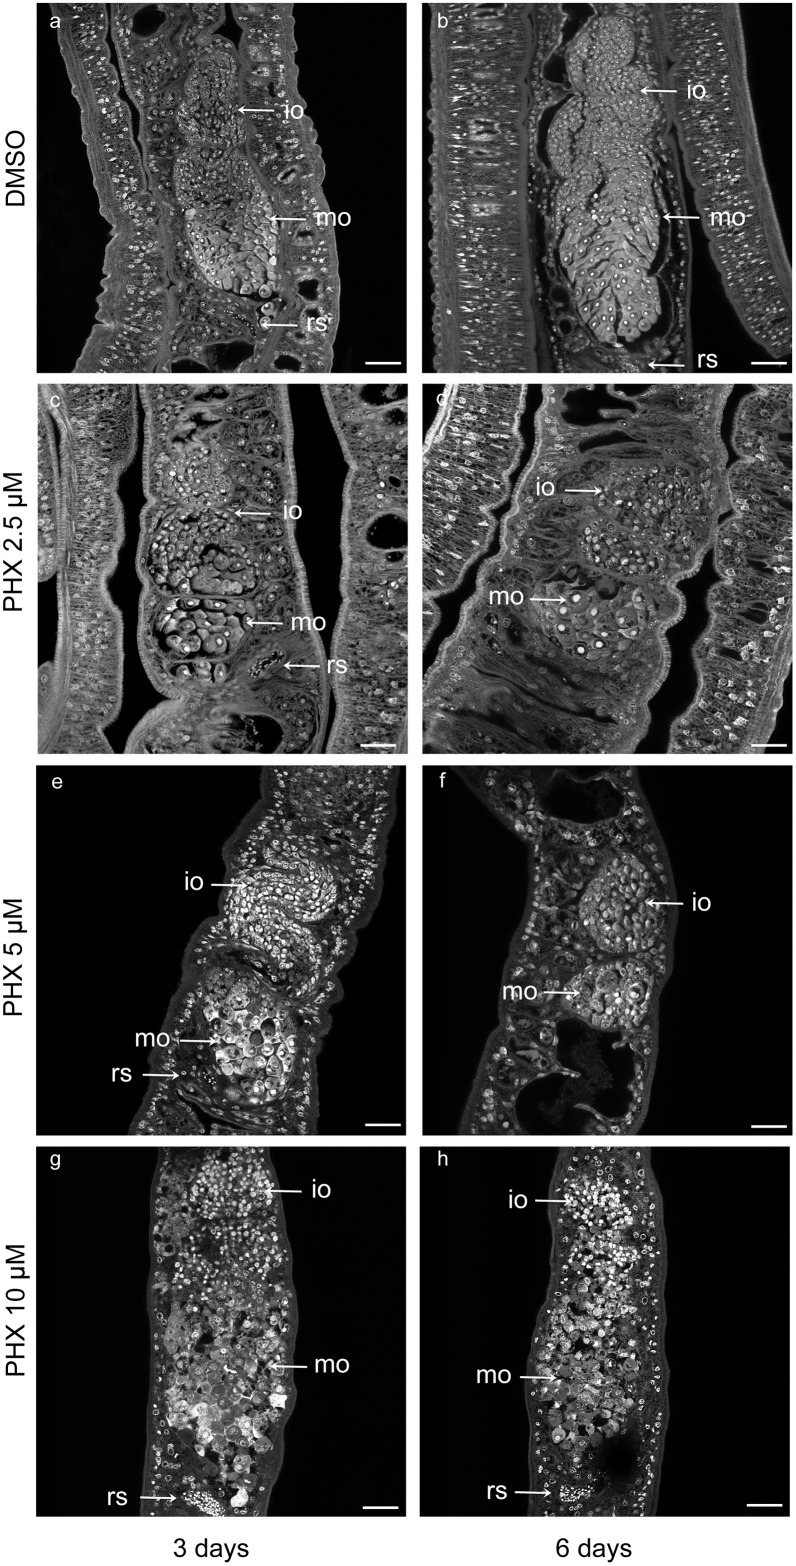
Ovary alterations in adult female worms treated with PHX.Representative confocal laser scanning microscope images of adult female ovaries. S. mansoni worm couples were treated for 3 and 6 days with DMSO (a, b) or different doses of PHX (c-h) for 3 and 6 days as indicated and stained with carmine red. Immature oocytes (io), mature oocytes (mo), receptaculum seminis (rs) are indicated. Scale bars = 50 μm (a-c), and 25 μm in all other PHX treated samples (d-h) are shown.